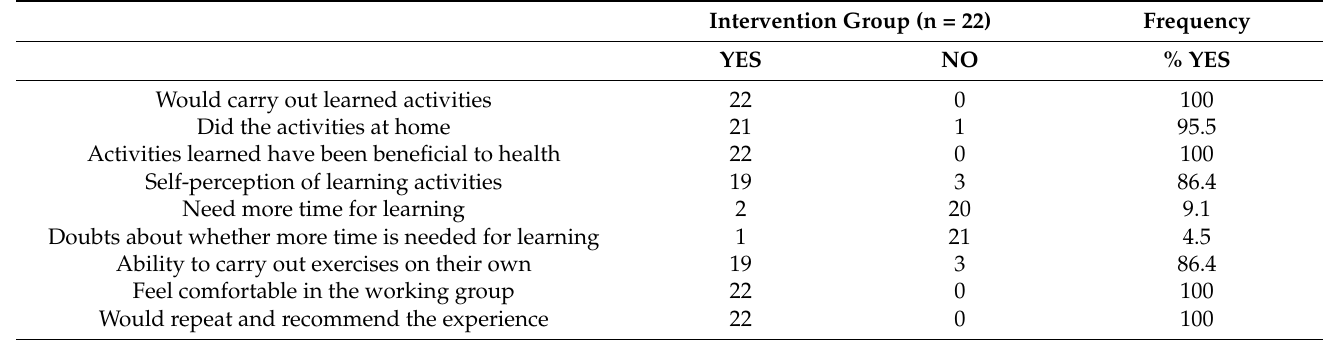
Table 4. Perceived satisfaction, usefulness, and learning vis- à -vis the PIPsE